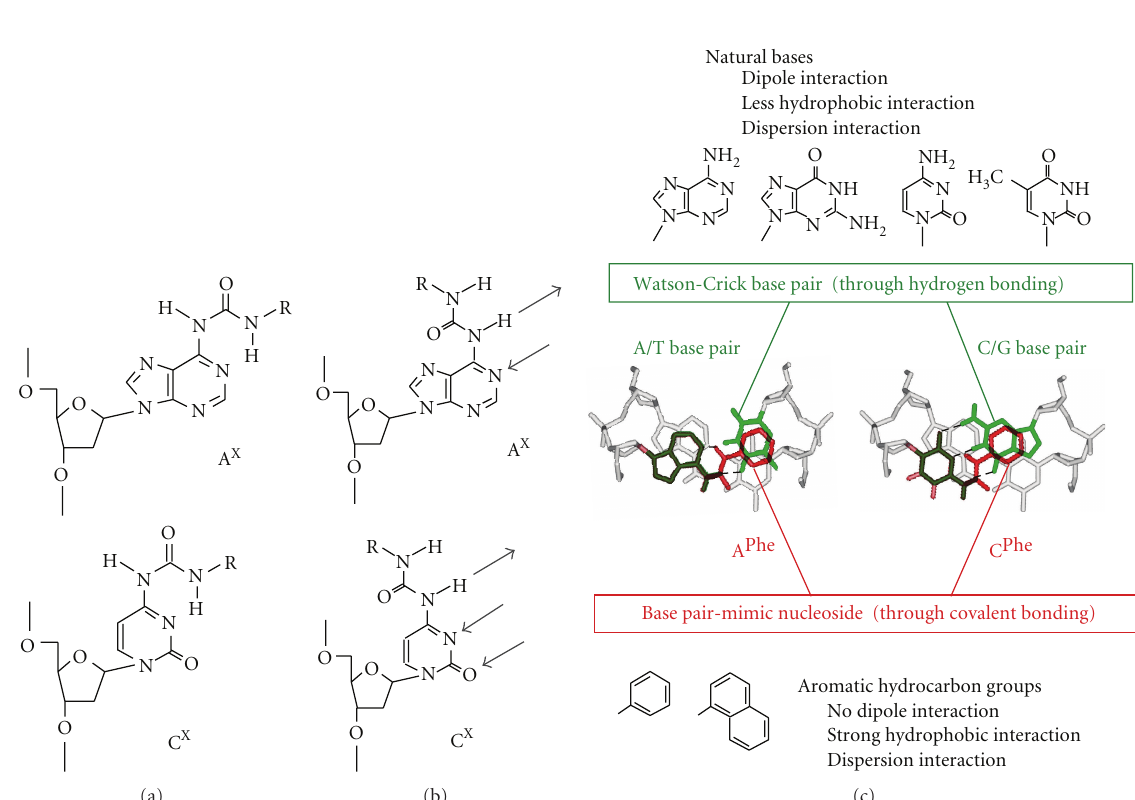
Figure 4: (a) and (b) Possible conformations of the deoxyadenosine and deoxycytidine derivatives, the nonpolar group stacking conformation (a) and the base pair conformation (b). indicates the phenyl or naphthyl group. The arrow indicates the site of hydrogen bonding with a complementary base. (c) Comparison of the major interaction forces for the stacking of the A/T and C/G base pairs and the stacking of the A phe and C phe . The nonpolar aromatic group in the base pair-mimic nucleosides is indicated in red, and the complementary base is indicated in